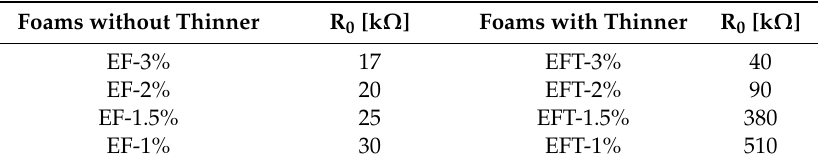
Table 2. Resistance values at rest condition of the foams loaded with di ff erent concentrations of graphene nanoplatelets